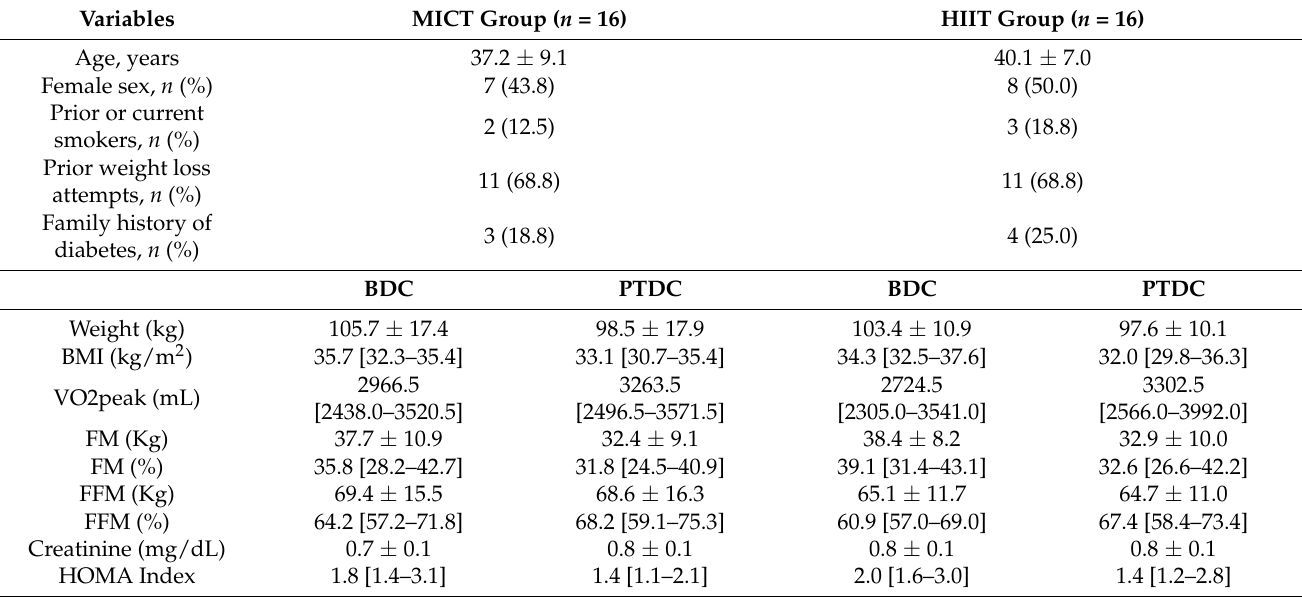
Table 1. Clinical, anthropometric and physical features by interventional group 1 .